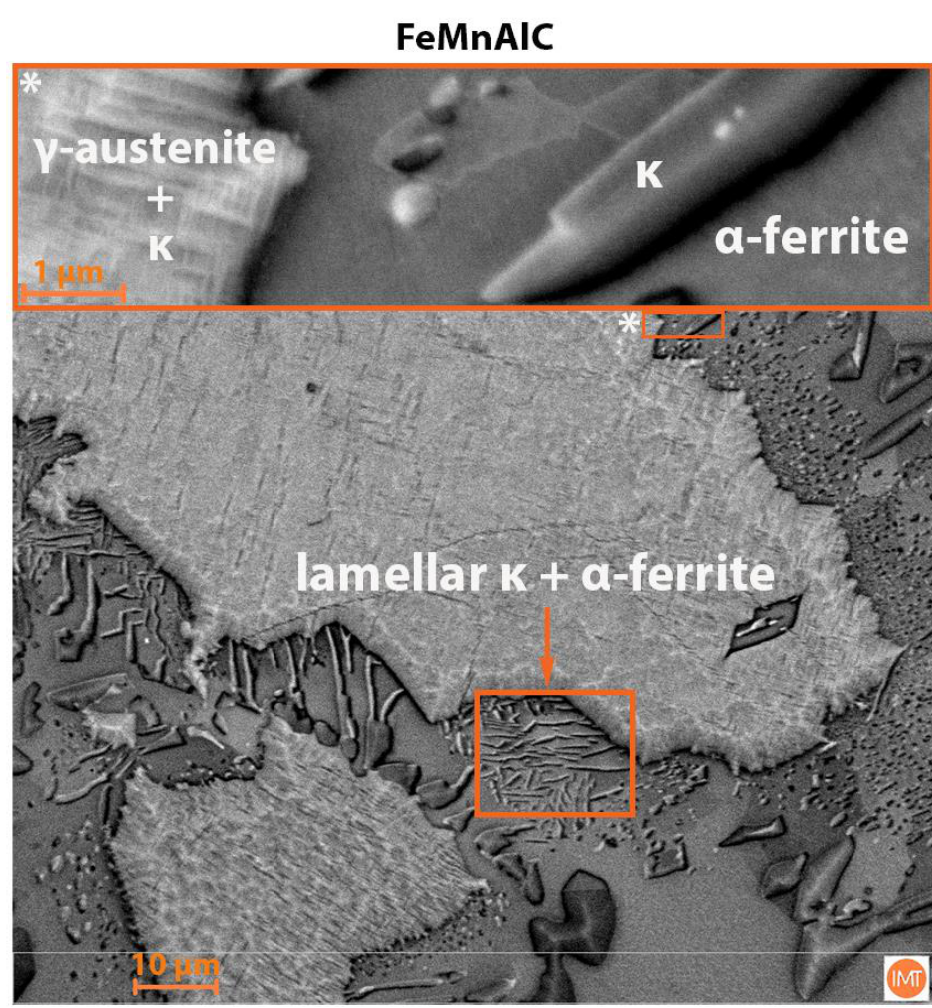
Figure 4. Lamellar morphology of kappa carbides. The microstructure of the sample with 5.6 wt.% Ni differs from the other samples, as the γ -austenite phase is almost completely decomposed. The SEM analysis shows the B2 ordered phase + kappa carbides and γ -austenite, while the α -ferrite grains remain stable, as can be seen in Figure 9. The closer examination of the former γ -austenite phase is shown in Figure 10. The microstructure of the decomposed γ -austenite consists of kappa carbides, B2 ordered phase and γ -austenite. The kappa carbides in γ -austenite are the result of spinodal decomposition as described by Mapelli et al. and Lu et al. [28,29]. The identification of kappa carbides and the ordered B2 phase can be difficult, but we distinguished them based on microchemical composition. The kappa carbides are richer in Al and Mn, while the B2 ordered phase contains more Ni. The remaining austenite is denser and can be seen as the brighter phase in backscattered electron